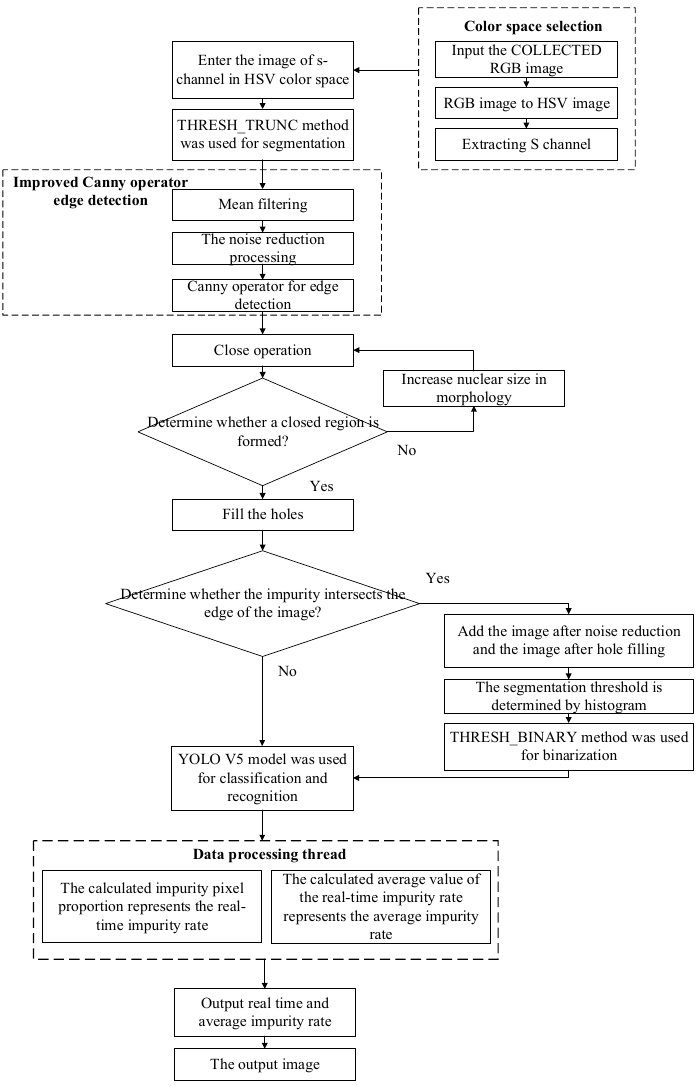
Figure 4. Flow chart of impurity content detection of machine-harvested seed cotton.